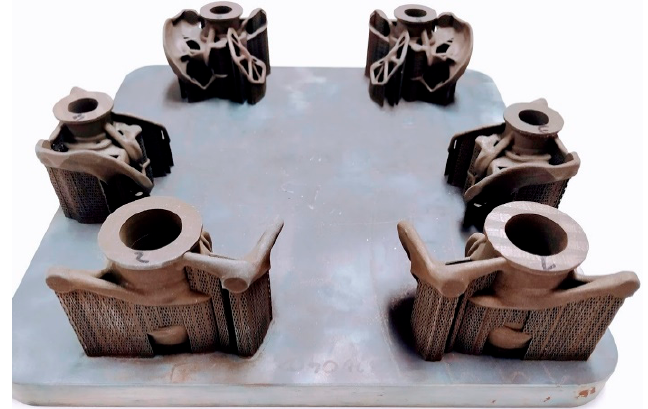
Figure 13. The 3D printed housings.